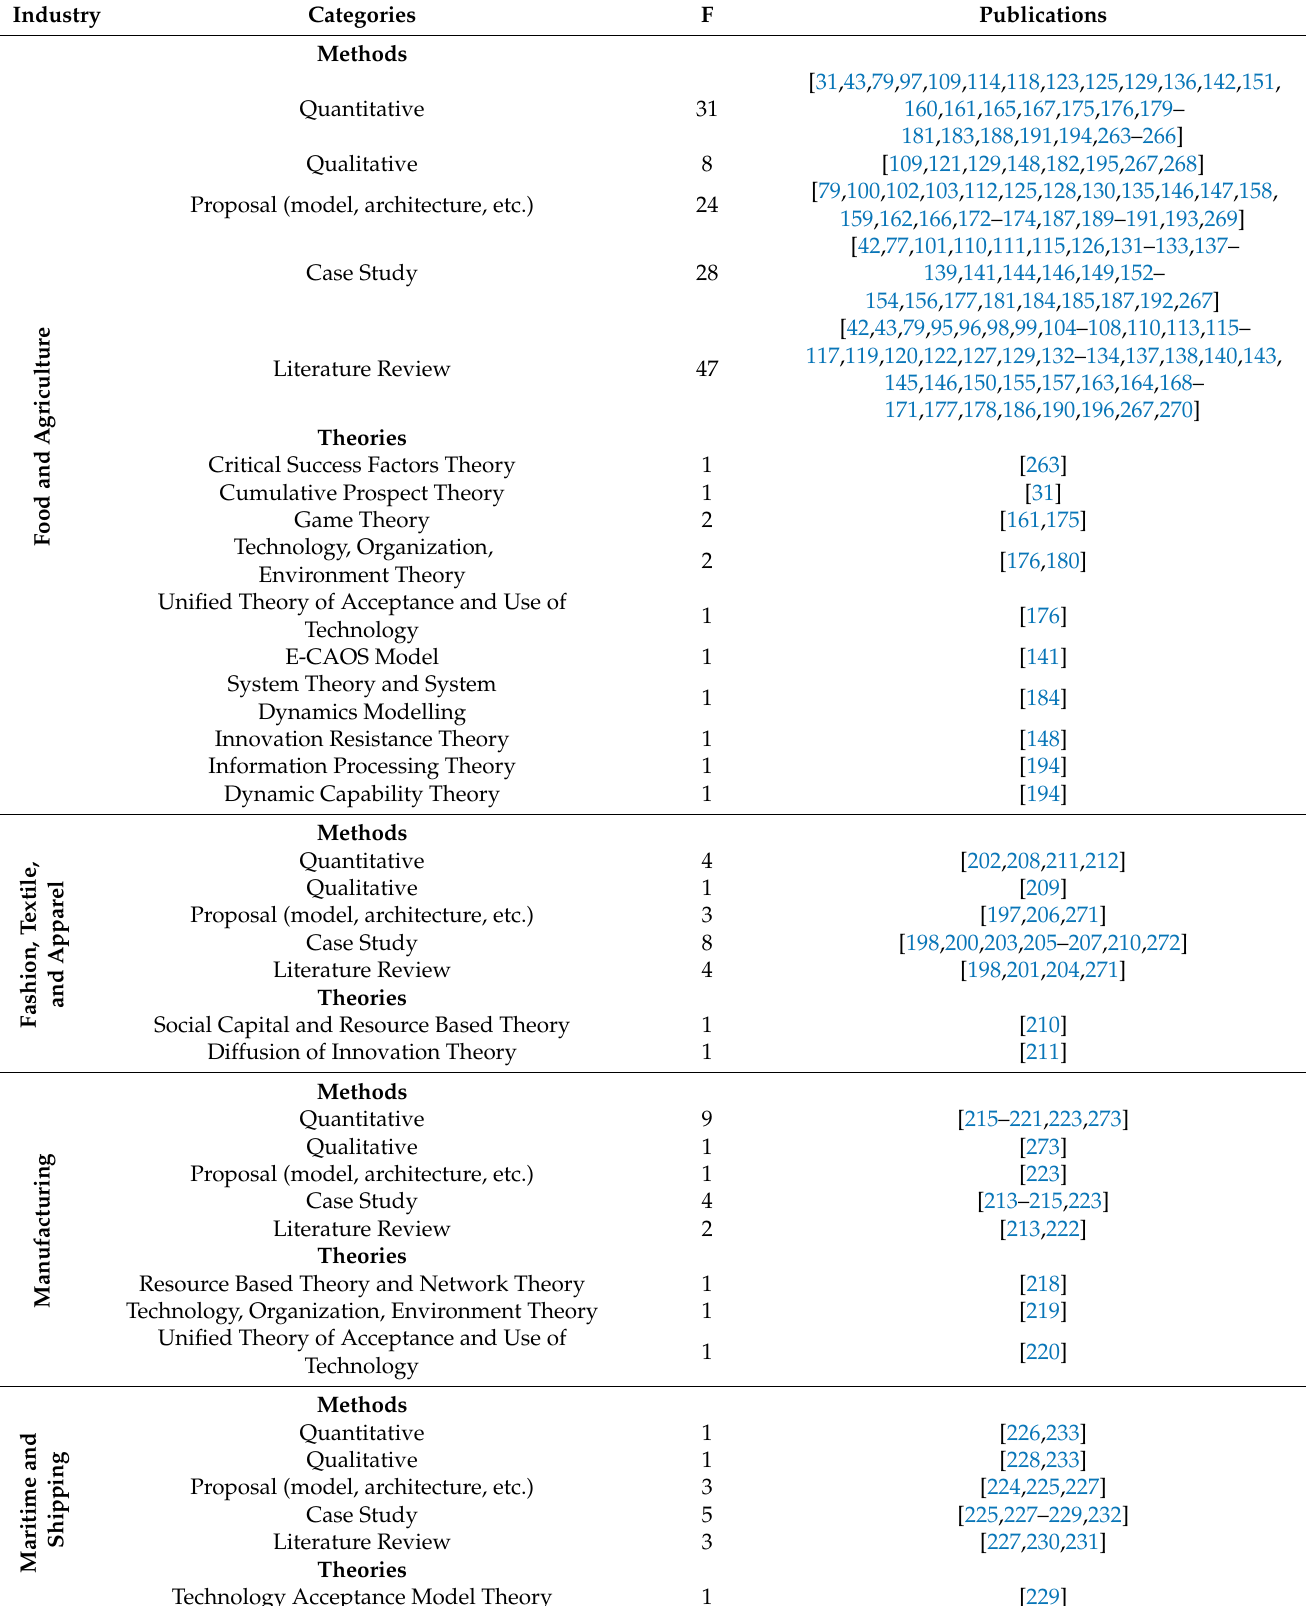
Table 5. Methods and Theories Used in the